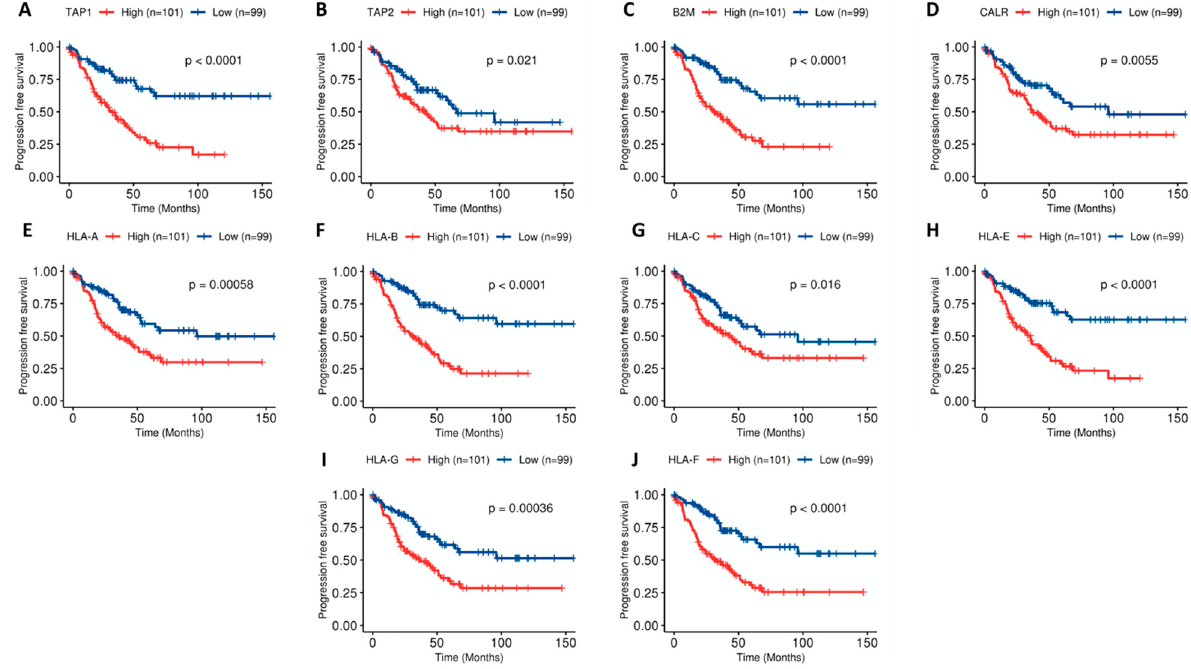
Figure 2. Kaplan-Meier survival curves with genes related to antigen processing and presentation machinery in uveal melanoma (UM) samples ( n = 200). Genes included are ( A ) tapasin-1 (TAP-1), ( B ) TAP-2, ( C ) beta-2-microglobulin (B2M), ( D ) calreticulin (CALR), ( E ) human leukocyte antigen-A (HLA-A), ( F ) HLA-B, ( G ) HLA-C, ( H ) HLA-E, ( I ) HLA-G, ( J ) HLA-F. Patients were divided into High and Low groups by the median value within each dataset and joined afterwards. p -values of Log-rank tests are indicated. High expression is painted in red whereas low expression is painted in blue.